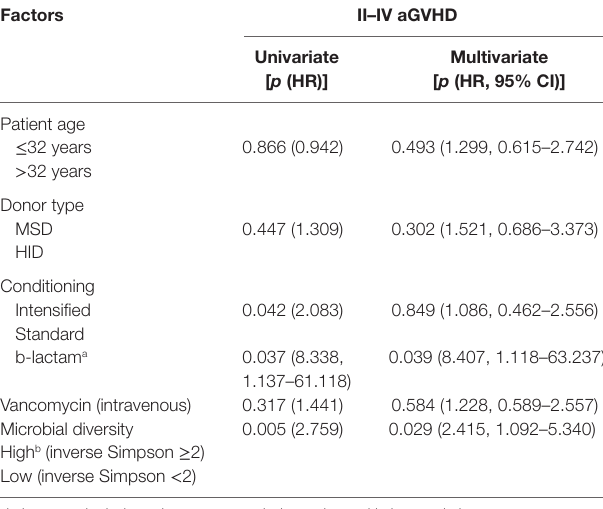
TaBle 2 | Multivariate analysis of acute graft-versus-host disease (aGVHD).